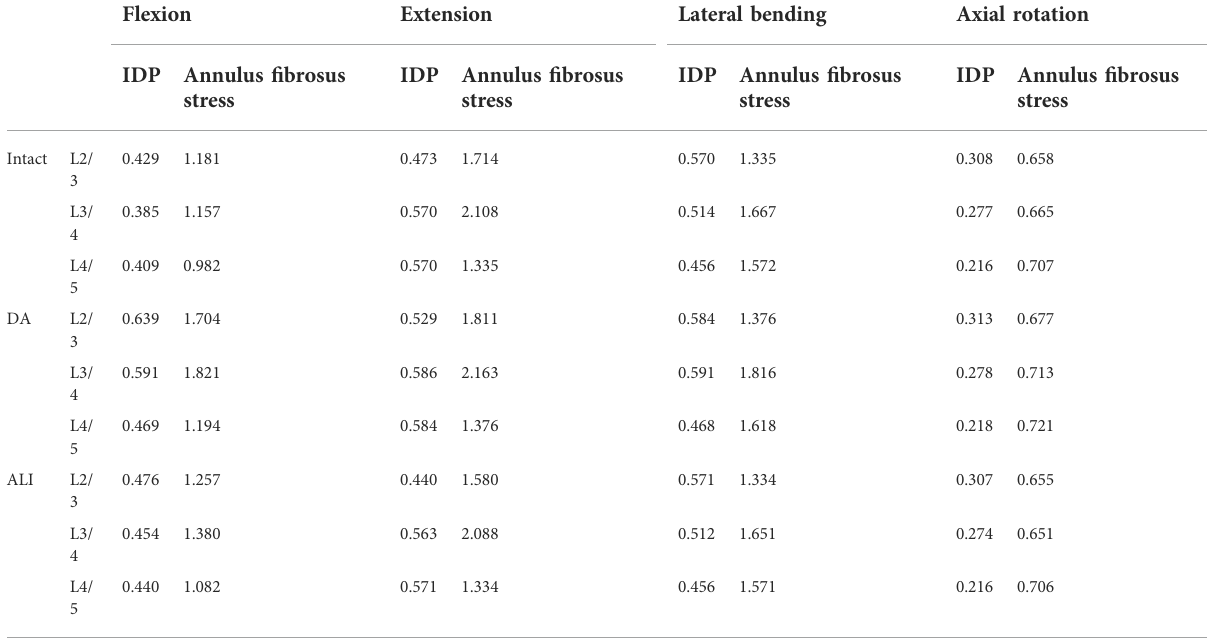
TABLE 3 Intradiscal pressure and maximum Von Mises stress of the annulus fi brosus